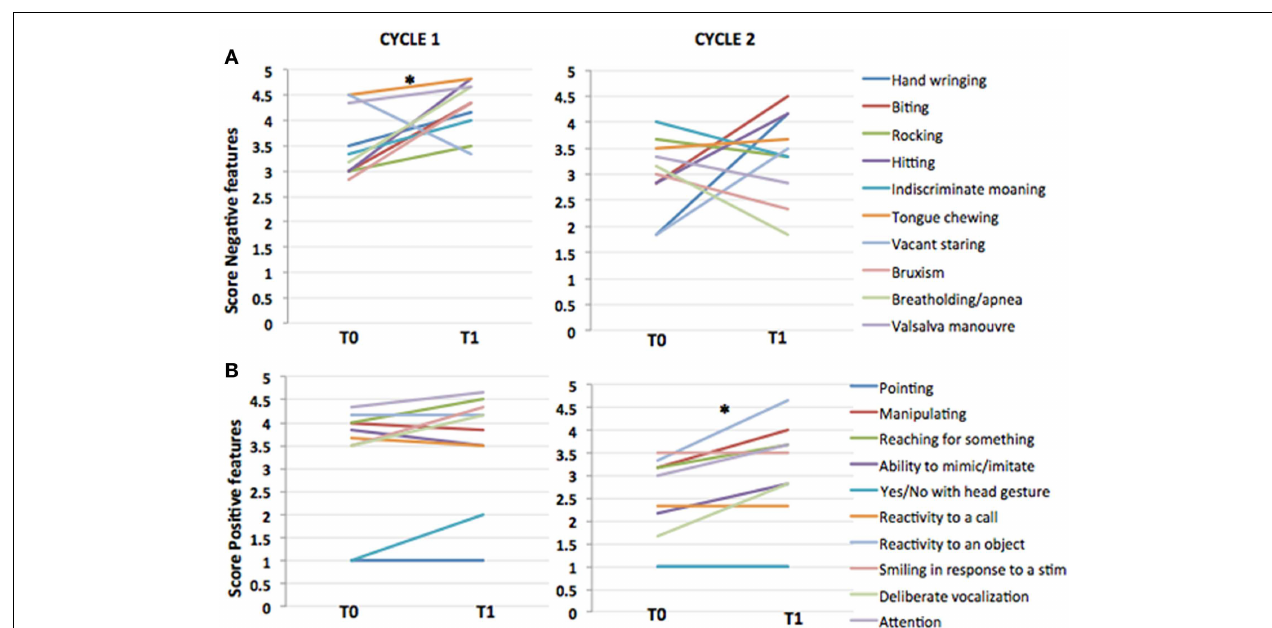
significantly negative features in cycle 1 (Wilcoxon test, p -value = 0.014), but not in cycle 2 (Wilcoxon test, p -value = 0.07).Viceversa, for positive features the effect was significant in cycle 2 (Wilcoxon test, p -value = 0.016), but not in cycle 1 (0.3).